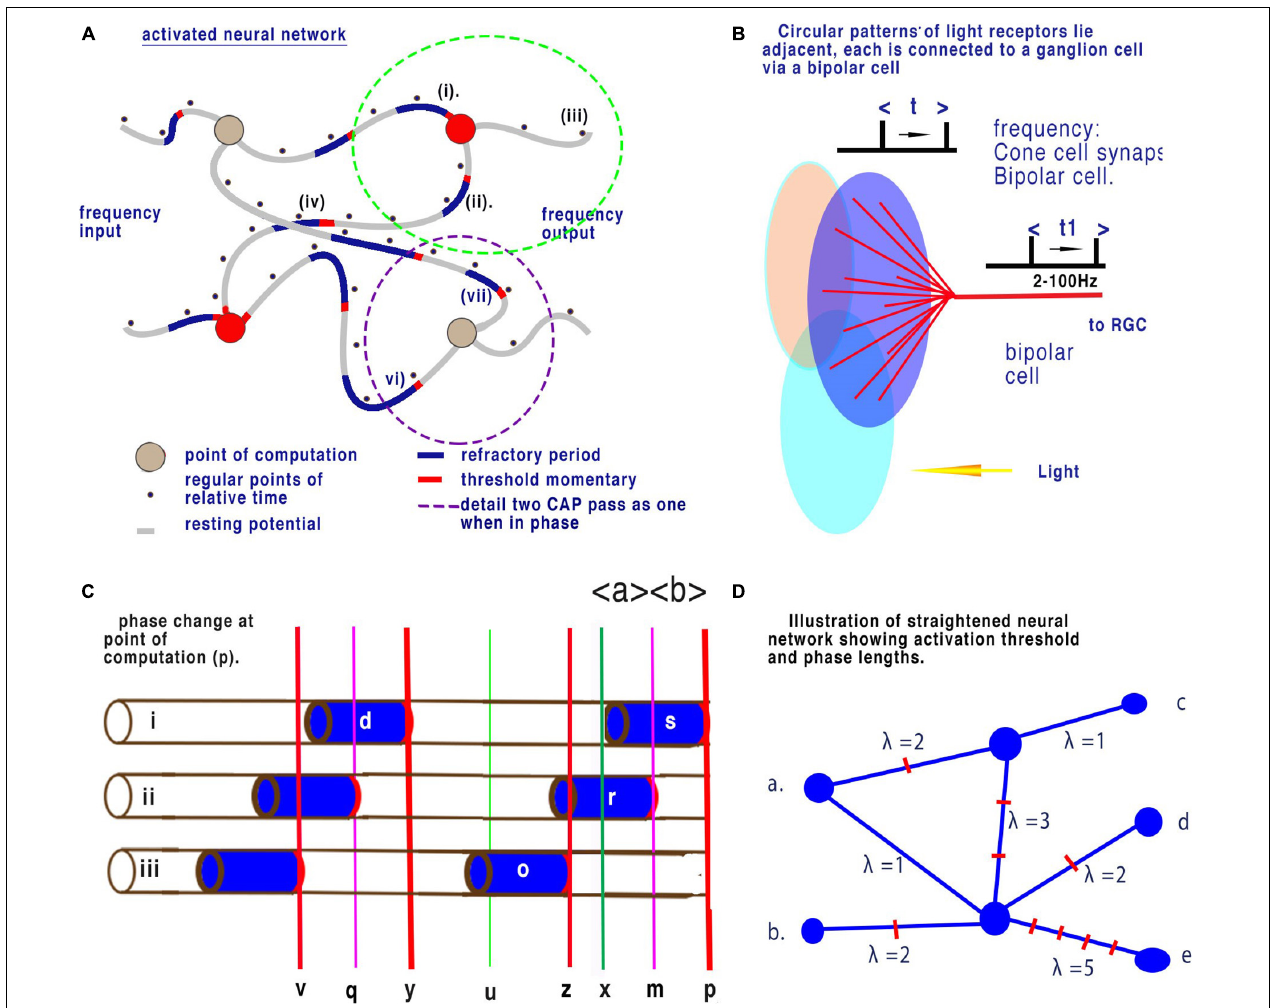
FIGURE 7 | Neural networks in the retina. (A) Illustration of a brain neural network showing changes in latency between nodes (from Johnson and Winlow, 2019). Panel (B) shows 12 cones (blue lines) converging upon a single bipolar cell (red lines). Here time, t1, changes relative to t. Panel (C) is an enlargement showing a succession of CAPs arriving at the point of computation (p). During fixed light intensity each cone will cause CAP’s to flow towards the point of computation (p) and CAPs are moving from left to right. Activation-thresholds that allow a CAP to continue after computation are shown by the red lines. All CAP in neurite (ii) are annulled. The time (p) to (x) is equivalent to the refractory period of the CAP of neuron (i). Refractory period (s) is selective and all other CAPs are annulled during this period. The result is that time between points of computation (z) to (p) is dependent upon only the time from the end of refractory period (x) to the next activation-threshold (z). This is then reflected in the spike timing from the RGCs. The interval (x) to (z) over any time period is a mean sample when calculated between successive CAPs. This results in the calculation of mean sampling by quantum phase ternary computation. Before collision the timing of each successive CAP along a neuron can be considered as a minute change in frequency. Panel (D) illustrates a straightened disordered brain neural network such as in Panel (A) . Frequencies of inputs (a) and (b) result in changes to frequency outputs (c), (d), and (e). In the network of (d) distances have been resolved into phase lengths of quanta. The network represents computation between different time dimensions illustrated by λ . As quanta arrive at different time at each node (between nodes quanta may arrive asynchronously but are digitised) convergence and interaction will take place where phases differ. This interaction will result in distinct changes in frequencies of output for distinct changes in frequencies of